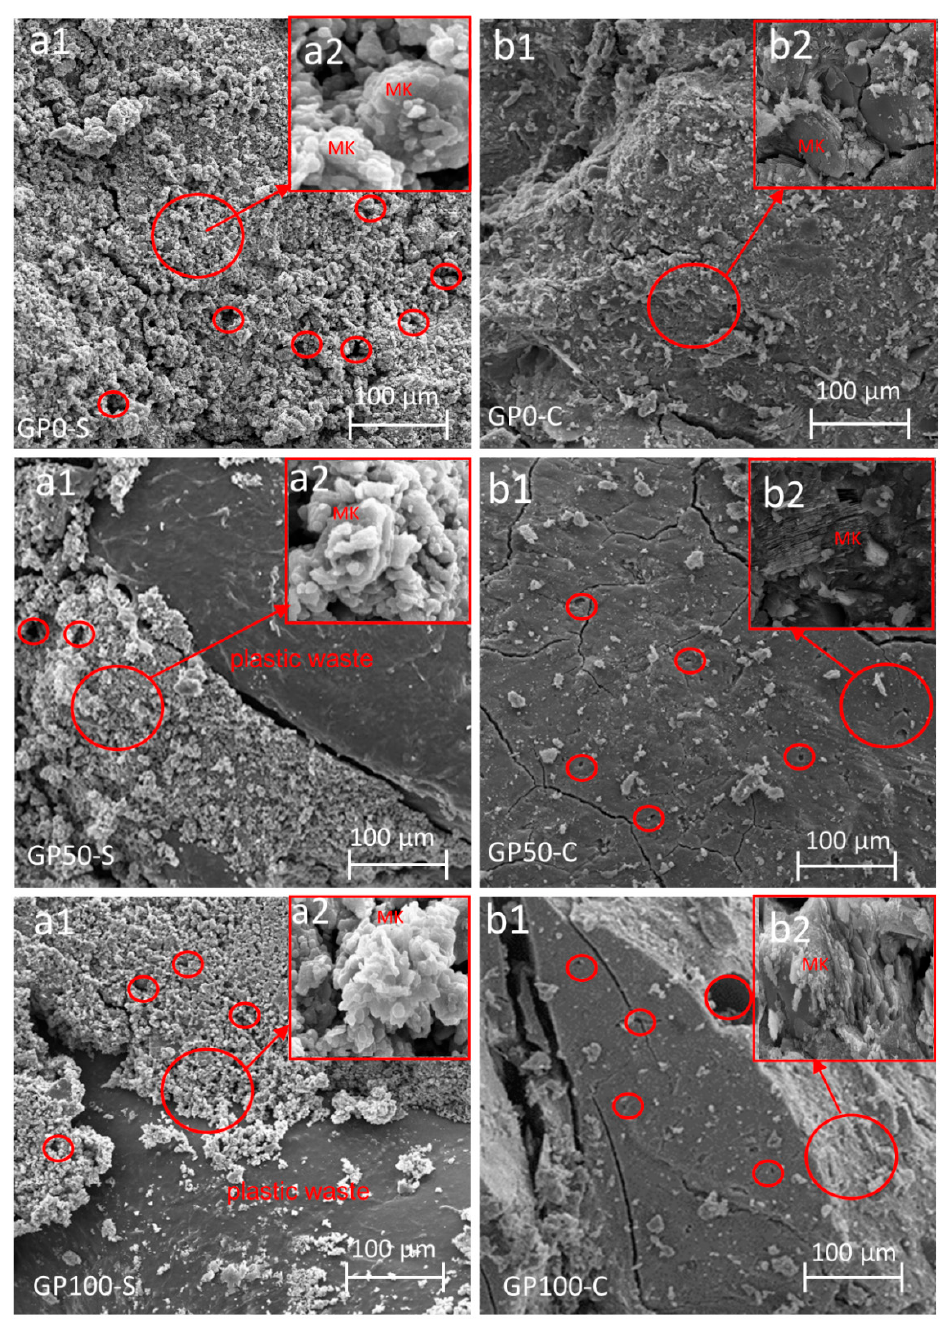
Figure 9. Morphology of the mortars GP0-S ( a1 , a2 ), GP50-S ( a1 , a2 ), GP100-S ( a1 , a2 ), GP0-C ( b1 , b2 ), GP50-C ( b1 , b2 ), and GP100-C ( b1 , b2 ) showing the enlarged area of unreacted material. The areas in the circles show the pores present in the sample.